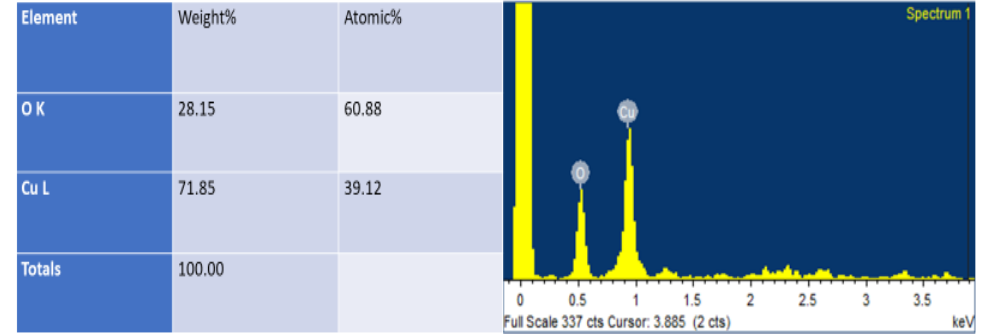
Figure 5. Energy dispersive X-ray Analysis (EDAX) results of Sg -CuO